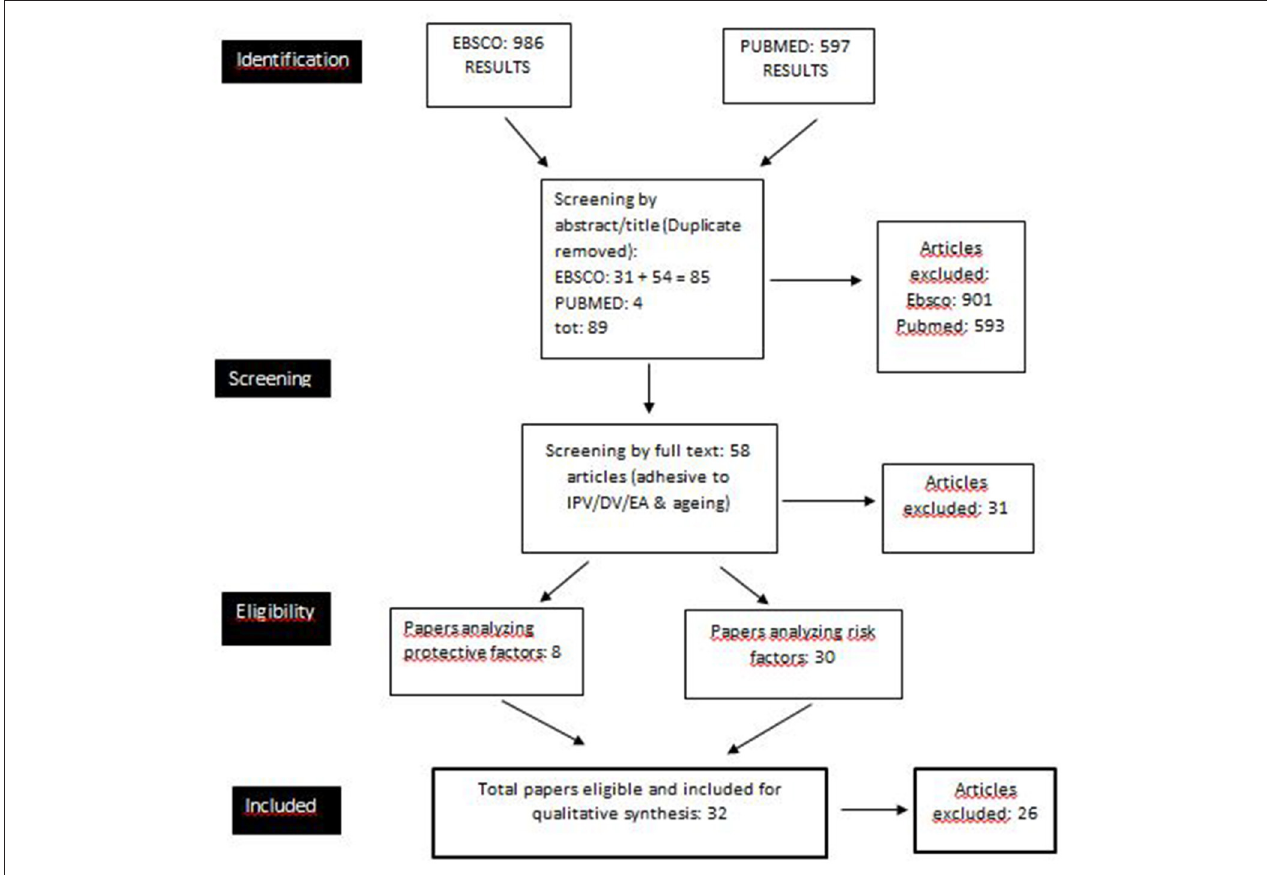
FIGURE 1 | Flow diagram of the selection